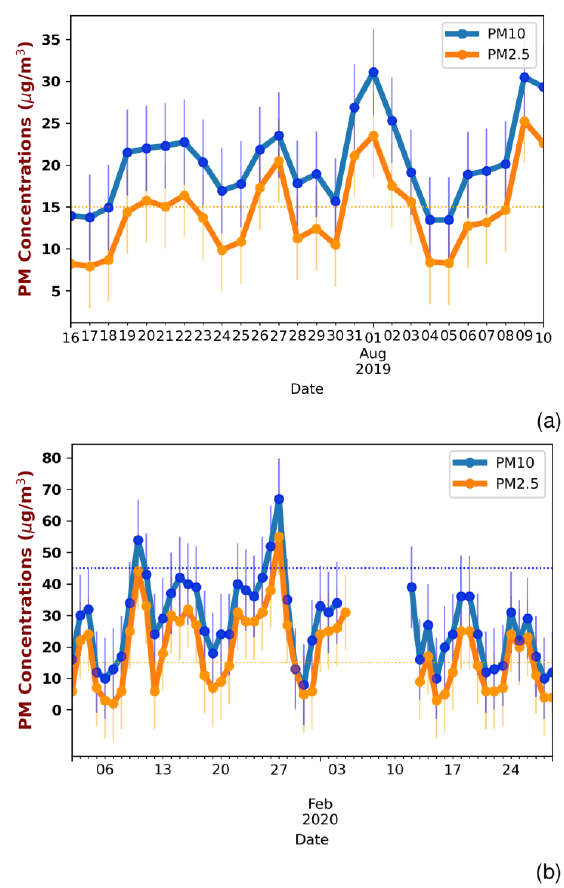
Figure 2. Daily mean variation, along with the standard deviation of the PM2.5 and PM10 concentra- tions monitored during ( a ) the summer and ( b ) winter PANACEA campaigns in Thessaloniki station. The PM2.5 and PM10 24-h mean limits, according to the WHO are also marked with dotted lines.